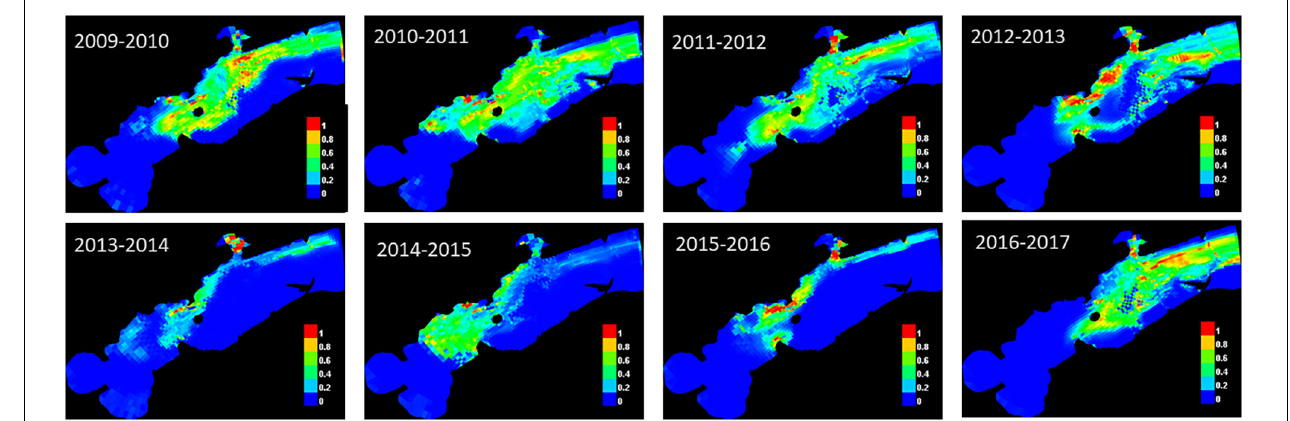
FIGURE 7 | Habitat suitability model results by each oyster year (2009/2010 through 2016/2017).